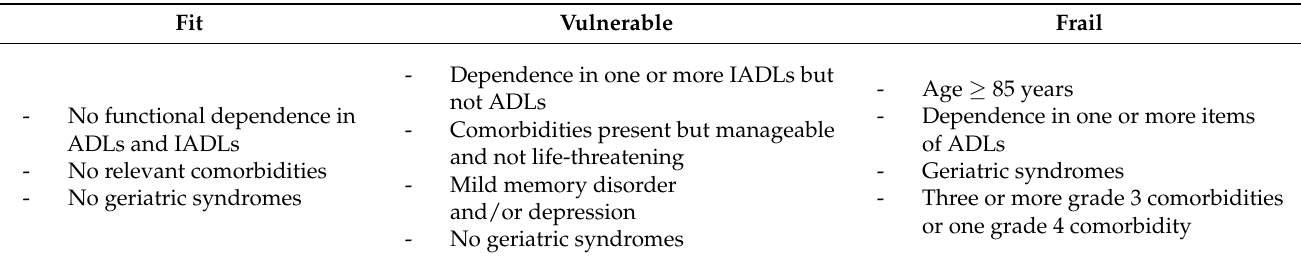
Table 1. Classification of patients according to Balducci’s